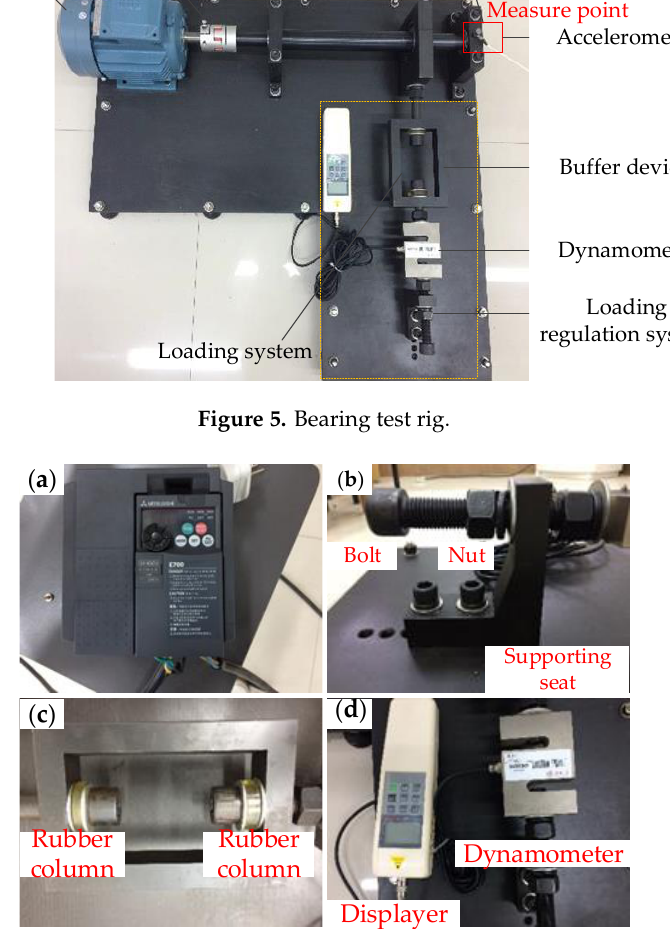
Figure 6. Platform components: ( a ) inverter and ( b – d ) loading regulation system.